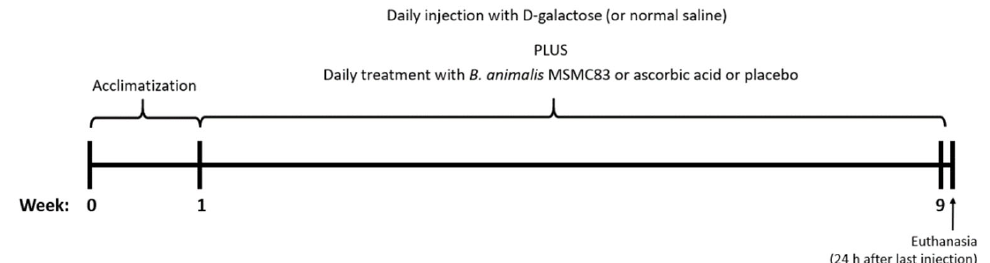
Figure 1. Visual presentation of experimental layout to induce accelerated oxidative stress via daily injections of D-galactose and administration of probiotic B. animalis MSMC83 or ascorbic acid .